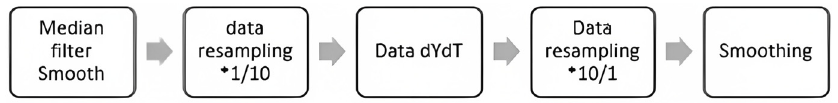
Figure 11. LIT101 sensor data process for extracting slopes.